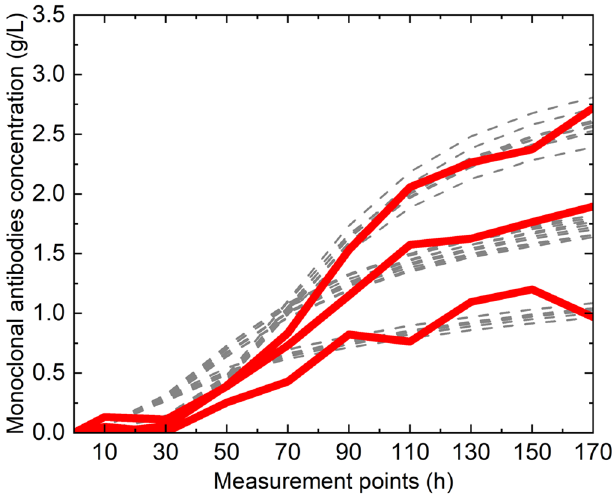
Figure 4. Example of batches generated through HDM: mAbs titer profiles. In this example, 10 batches are generated from 3 training batches taken from the process. The thick red continuous lines represent the training batches while the grey dashed lines represent the simulated ones.